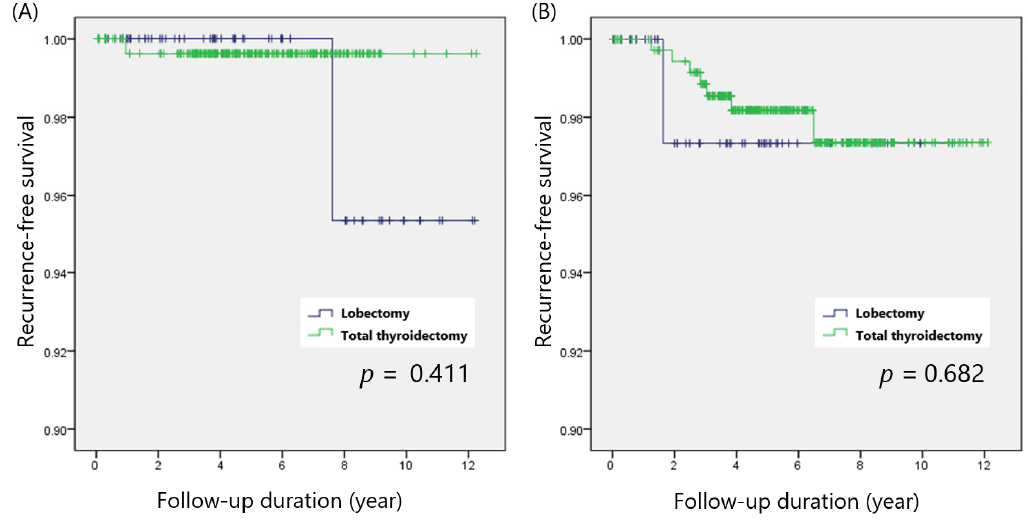
Figure 4. Recurrence-free survival in patients with ( A ) ATA low risk and ( B ) intermediate risk.